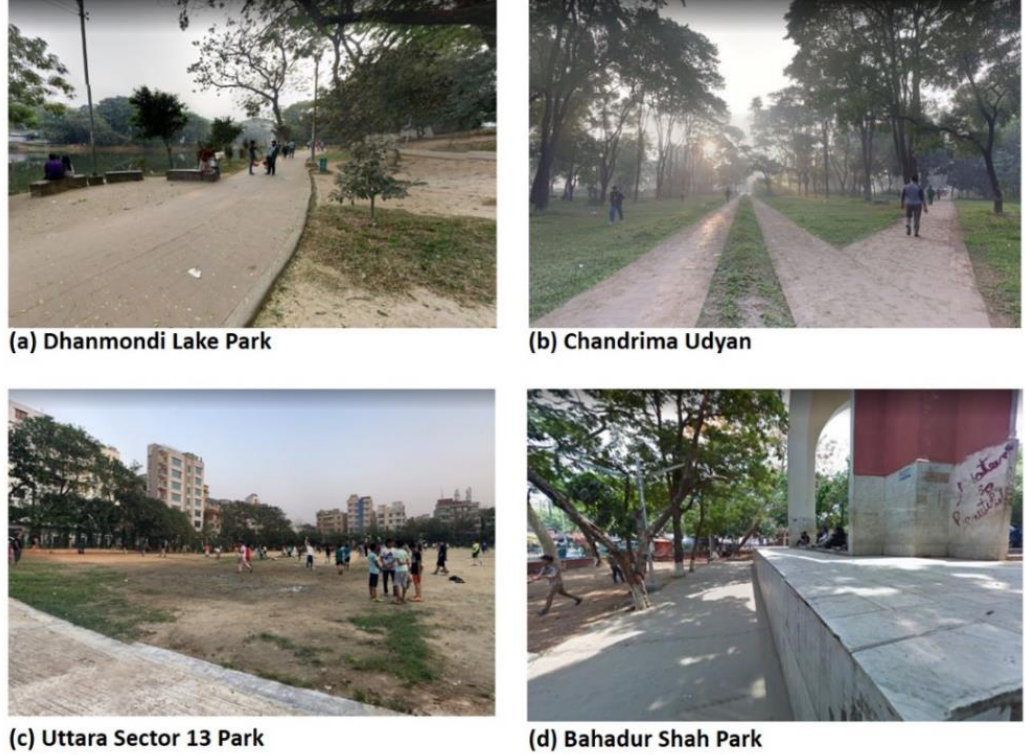
Figure 2. Examples of the conditions of urban green spaces in Dhaka City, Bangladesh ( a – d ). Images were collected from Google Street View.